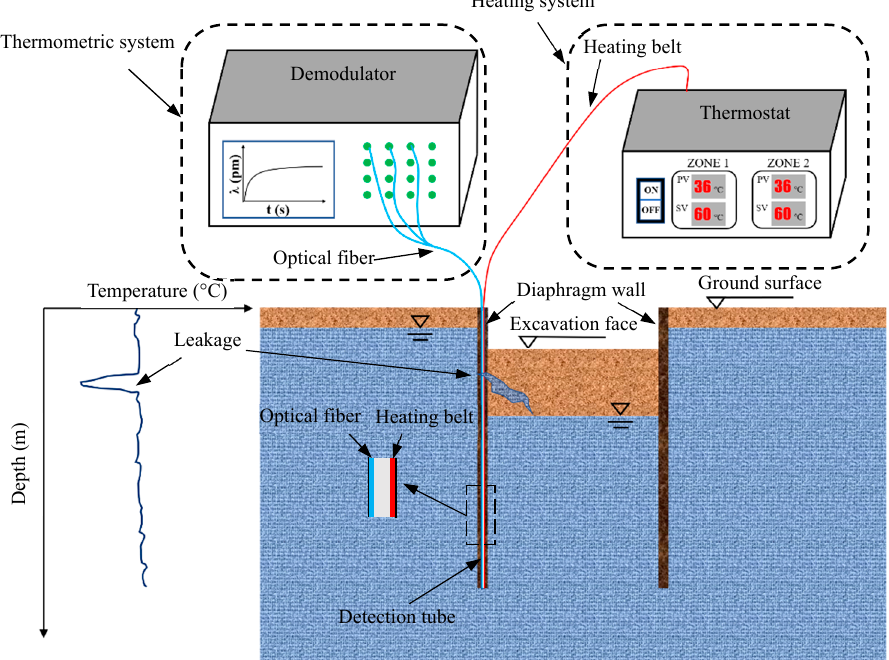
Figure 1. Diagram illustrating the leakage detection system for diaphragm wall joints (LDS-DWJ). The temperature measured using the fiber Bragg grating (FBG) sensors fluctuates at the point where the fiber encounters water leakage (modified from Zheng et al., 2020 [15]).